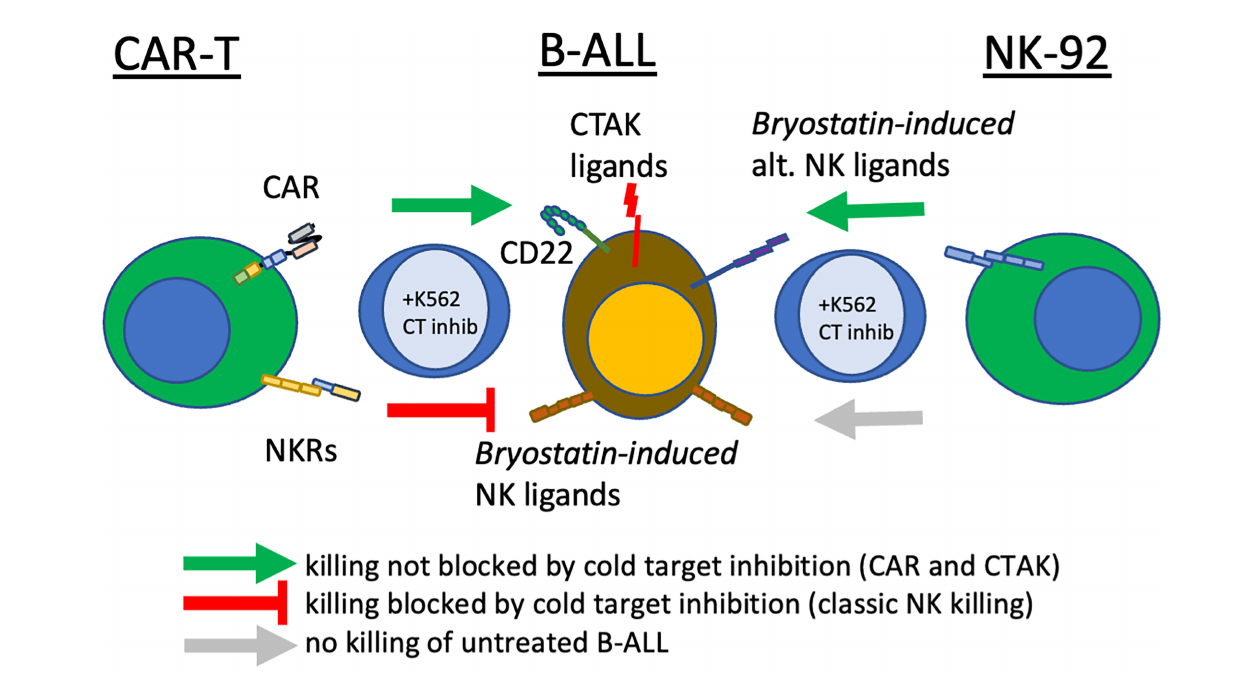
FIGURE 8 | Bryostatin treatment reveals multiple pathways that CAR-T cells use to eliminate leukemia. In the center of the diagram, pre-B ALL cells are illustrated, displaying the CAR-T target antigen, CD22, innate immune receptor ligands induced by bryostatin that are recognized by activated T cells (Bryostatin-induced NK ligands) and ligands recognized by T cells that have been: a) sensitized by CAR-T production, b) bryostatin-induced, and c) not blocked by cold-target inhibition (CTAK, CAR-T cell non-antigen-speci fi c killing). Also shown are a non-overlapping set of alternative innate immune receptor ligands that are recognized by NK92 upon bryostatin-treatment (right-most effector cell). Cold-target inhibition does not affect NK92 or CD22-speci fi c CAR-T killing. Cold-target does decrease killing evidenced by activated T cells (UTD), but incompletely for CTAK-mediated killing. Green arrows indicate successful cytolysis and blunt red arrow indicates killing impacted by K562-mediated cold target inhibition (classic NK